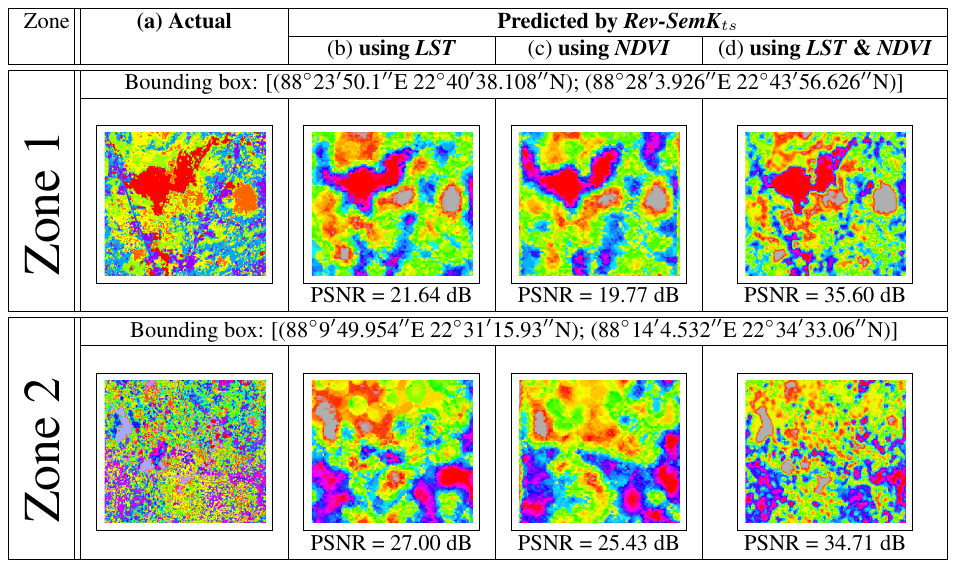
Table 1. Comparison study with (a) actual LULC distribution imagery, and the predicted imagery (b) using Rev-SemK ts with LST , (c)